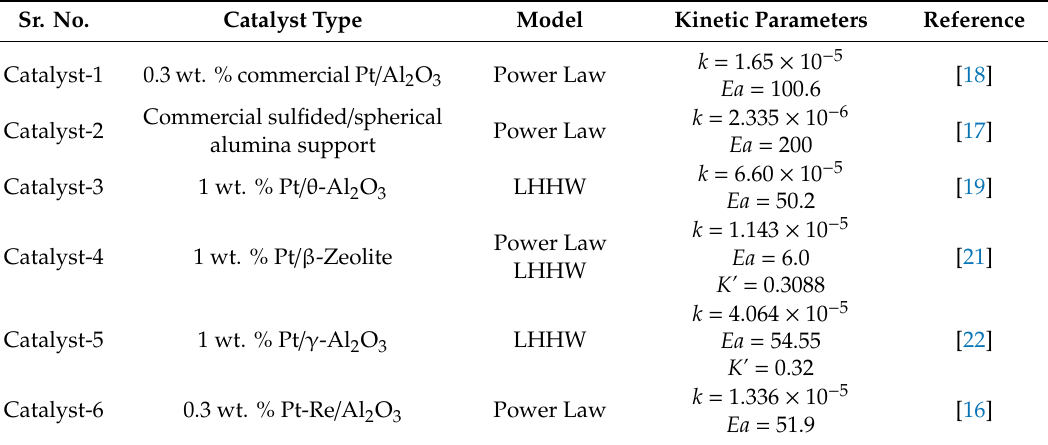
Table 6. Catalysts used for the study.